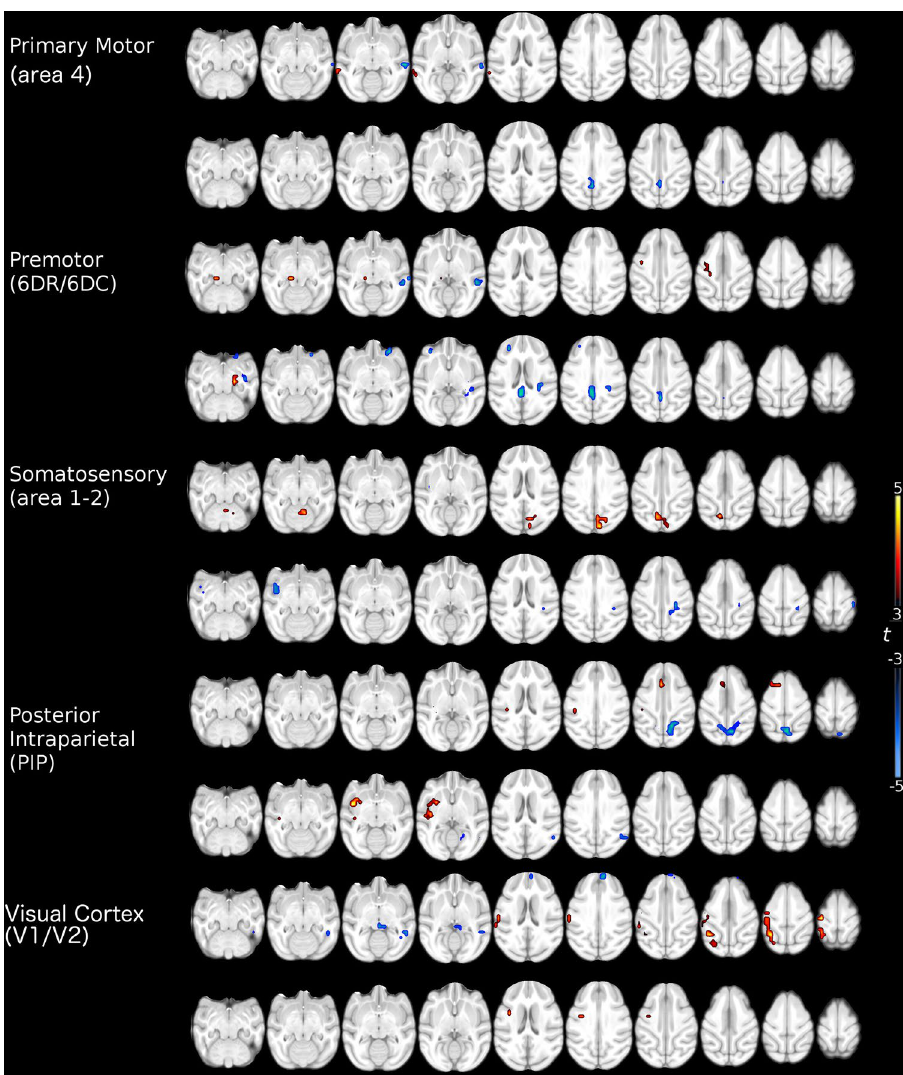
Figure 2. Significant functional connectivity differences between healthy controls and stroke primates. Warm colors indicate an increase and cold colors indicate a decrease in the functional connectivity on the stroke group (11 subjects). Maps corrected for multiple comparison using False Discovery Rate (FDR) p <